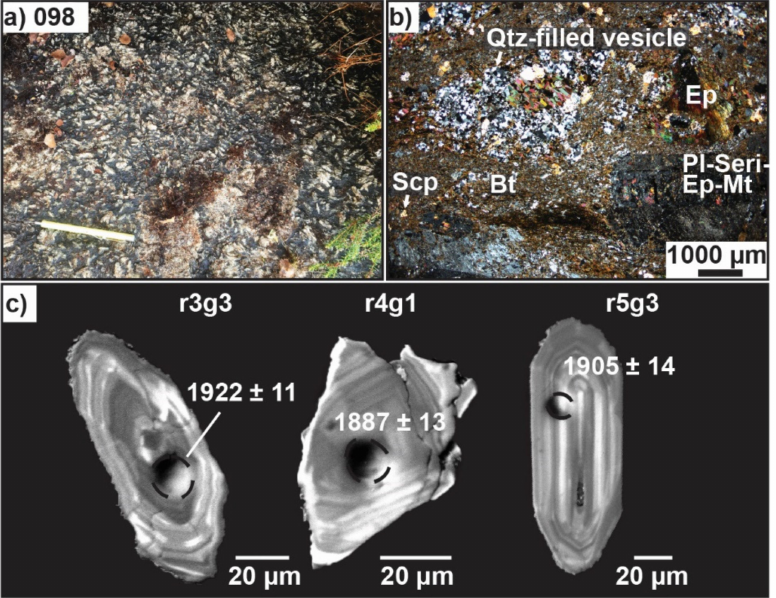
Figure 6. Sample images from the Pahtohavare area. ( a ) Sample 098 in outcrop showing large plagioclase laths in a fine-grained biotite-rich matrix. Mineral orientation varies from unoriented to oriented. ( b ) Micrograph in XPL of sample 098 porphyritic texture with large plagioclase laths converting into white mica–epidote–magnetite. Scapolite porphyroblasts occur in the biotite-rich matrix. ( c ) Cathodoluminescence images of typical zircon grains for sample 098. Dashed white and black circles highlight each concordant SIMS spot analysis while red circles and text are